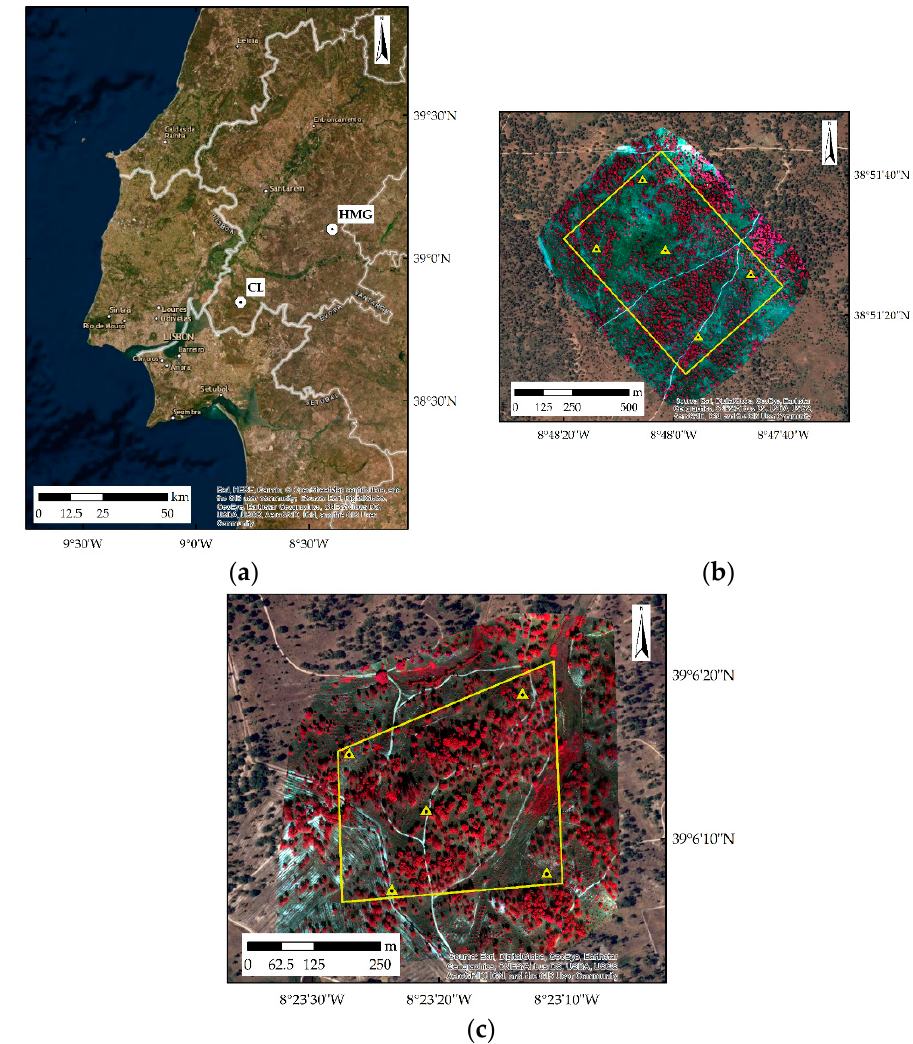
Figure 1. ( a ) Test sites location (white dots) approximately 50 km (CL) and 100 km (HMG) northeast of Lisbon; ( b ) Companhia das Lezírias (CL) and ( c ) Herdade da Machoqueira do Grou (HMG). Yellow polygons represent the limits of the test sites and yellow triangles the location of the ground control points (CGPs).